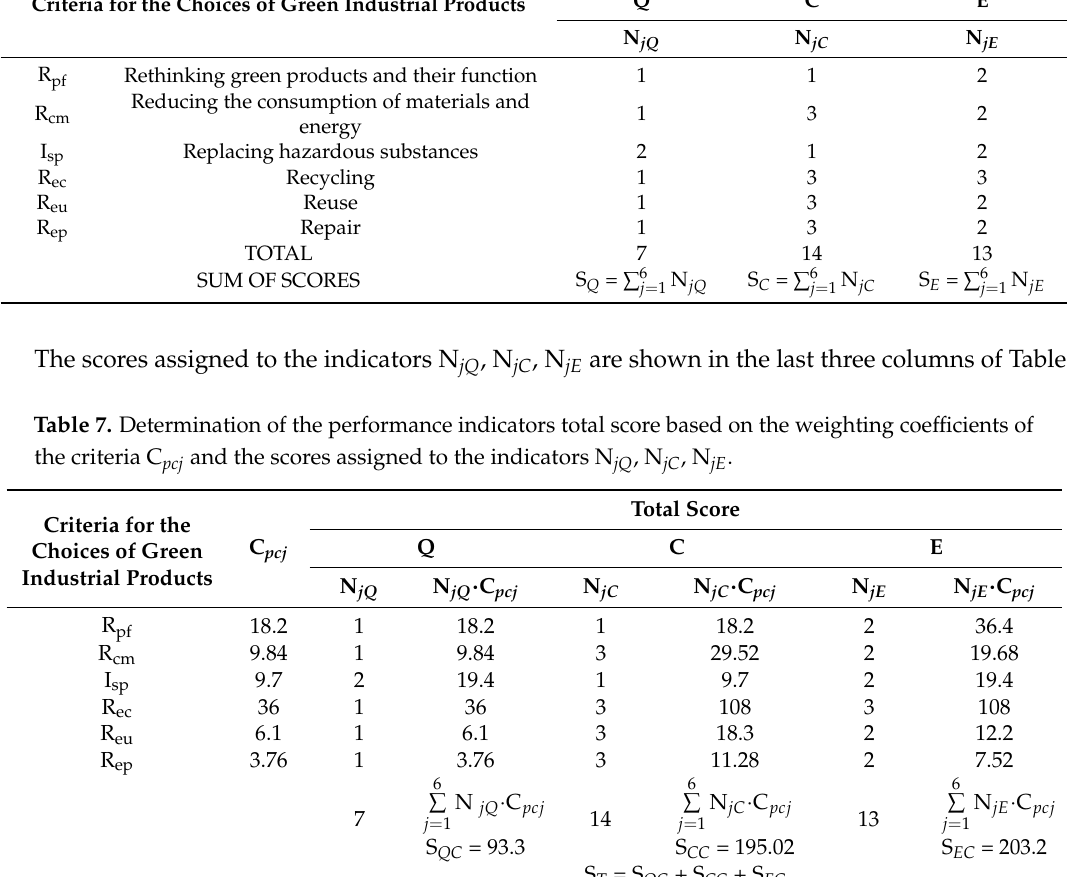
Table 6. Criteria and scores for the choices of the green industrial product “Urban Crosstown Bus”. Scores for the N j Criteria Q C E Criteria for the Choices of Green Industrial Products N jQ N jC N jE R pf Rethinking green products and their function 1 1 2 Reducing the consumption of materials and 1 3 2 R cm energy I sp Replacing hazardous substances 2 Recycling